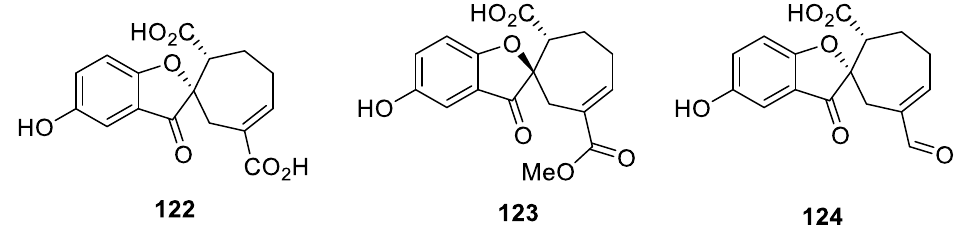
Figure 59. Spiro meroterpenoids spiroapplanatumines ( 122 – 124 ) isolated from fungus Ganoderma applanatum .